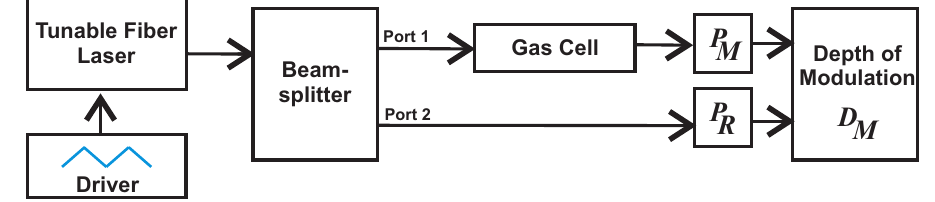
Figure 2. Block diagram of a Direct Absorption Tunable Laser Absorption Spectroscopy (DA-ATLAS) sensor with two optical